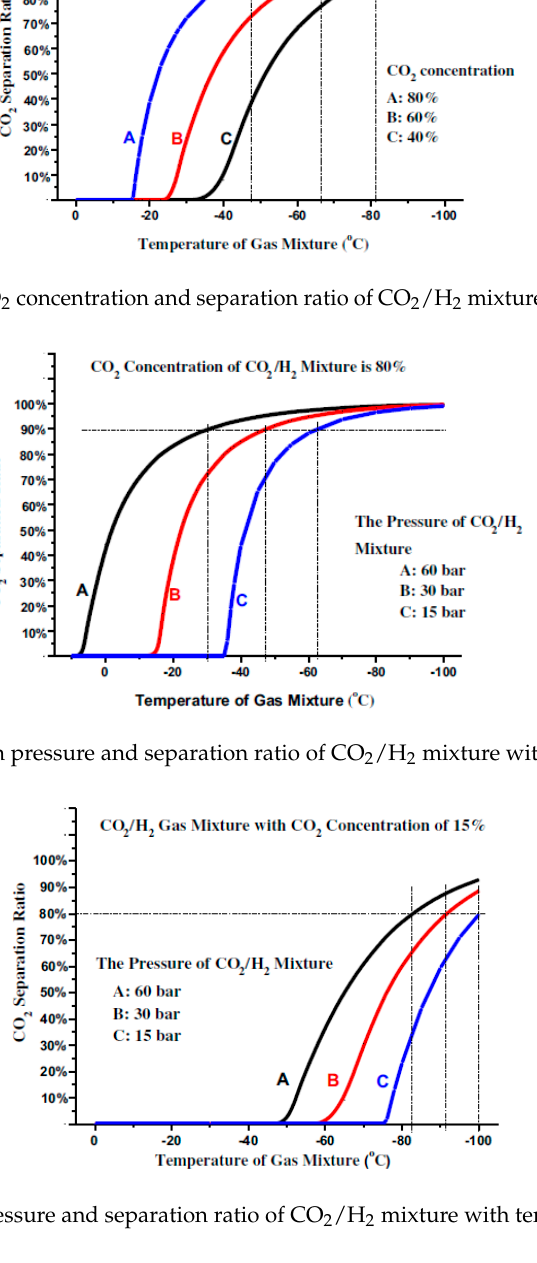
Figure 2. Variation in CO 2 concentration and separation ratio of CO 2 /H 2 mixture with temperature [8].